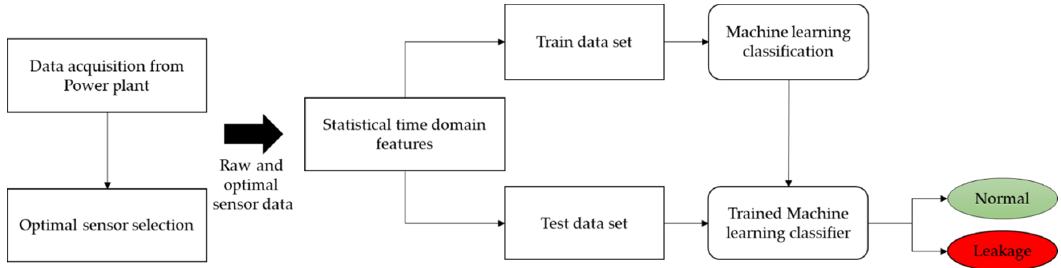
Figure 5. Schematic of the machine learning process used to predict the boiler health state.